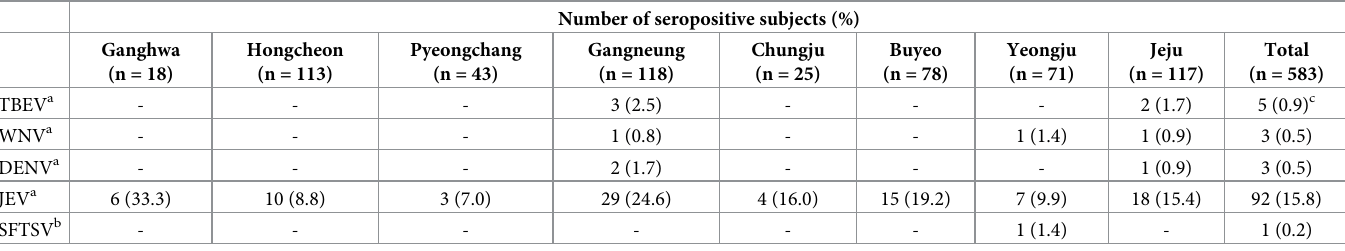
Table 2. Seroprevalence of TBEV, WNV, DENV, JEV, and SFTSV in South Korean forest/field workers.